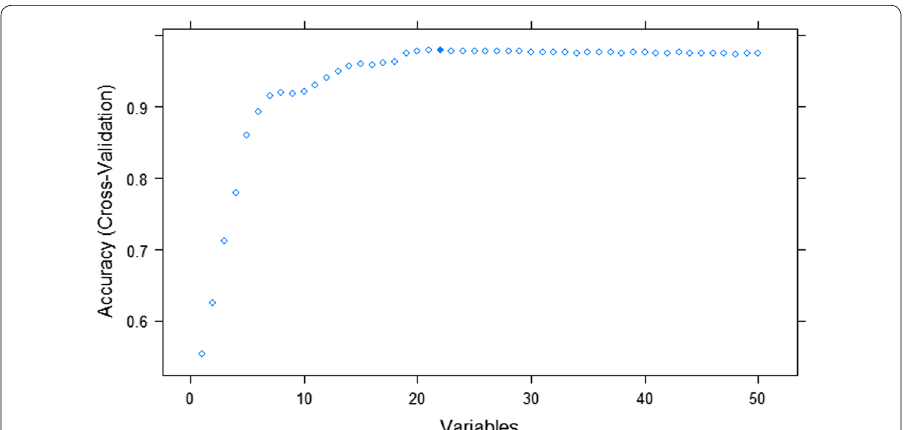
Fig. 11 The important measure for each variable of Human Activity Recognition Using Smartphones Dataset using Recursive Features Elimination